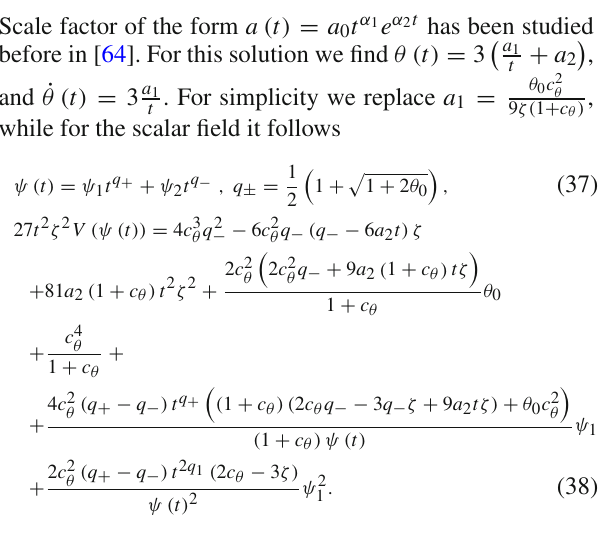
= 3 a 2 ( 1 + c θ ) , V D where V D 0 2 values of the free